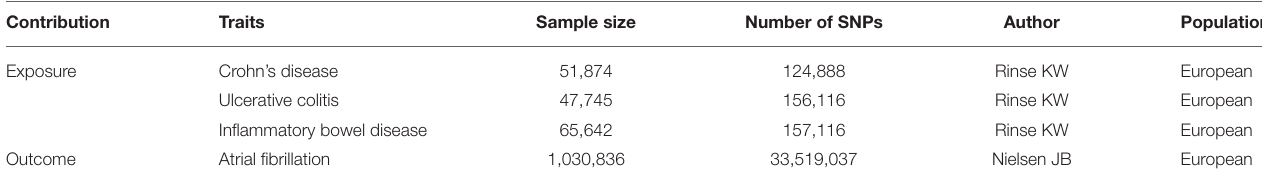
TABLE 1 | Description of contributing studies.